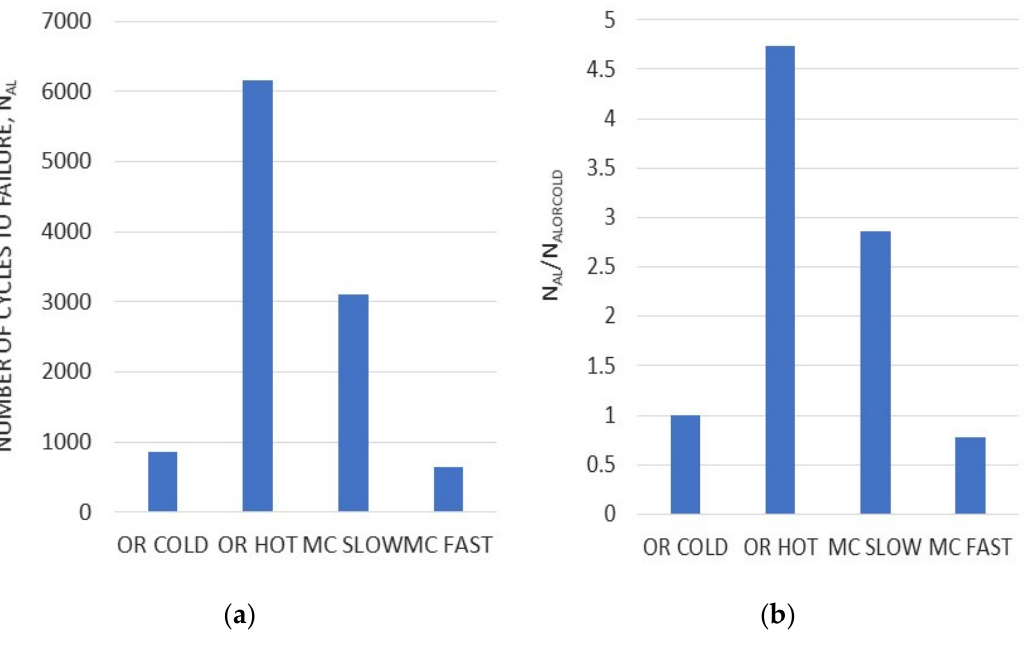
Figure 16. The estimated fatigue life for each startup scenario, showing ( a ) the number of cycles to failure and ( b ) the ratios of fatigue lives.